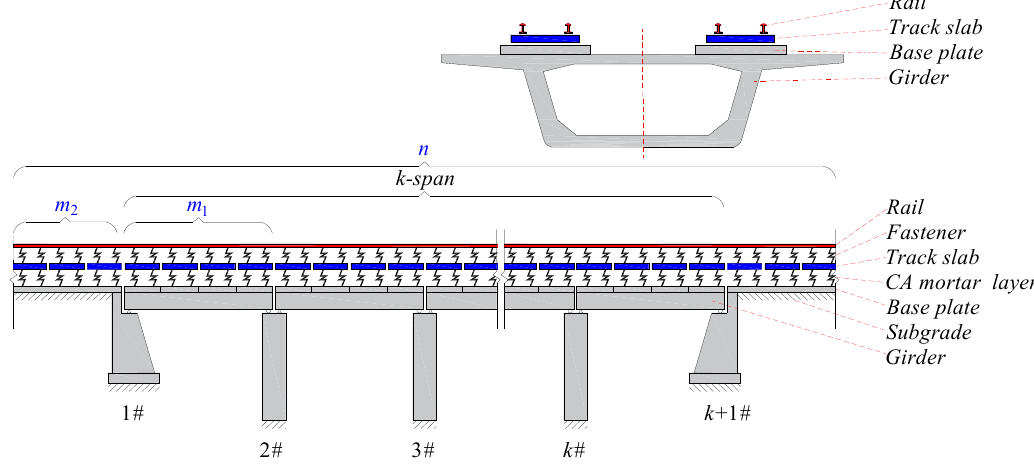
Figure 1. Schematic drawing of a unit slab-type ballastless track-bridge system of HSR.